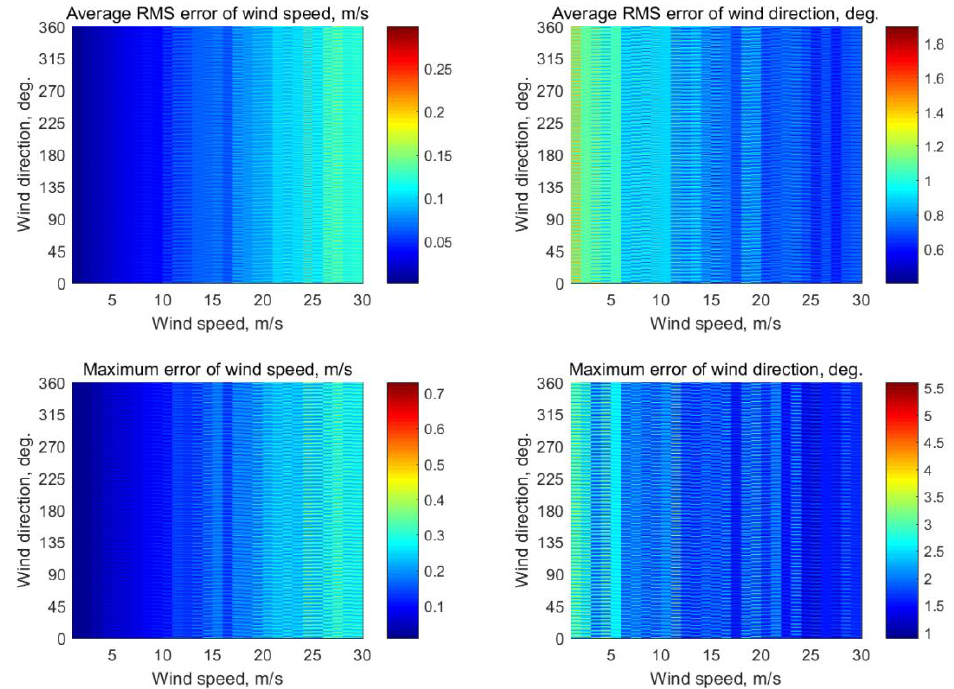
Figure A16. Simulation results of the use of three incidence angles of 40 ◦ , 45 ◦ , and 50 ◦ for wind retrieval.